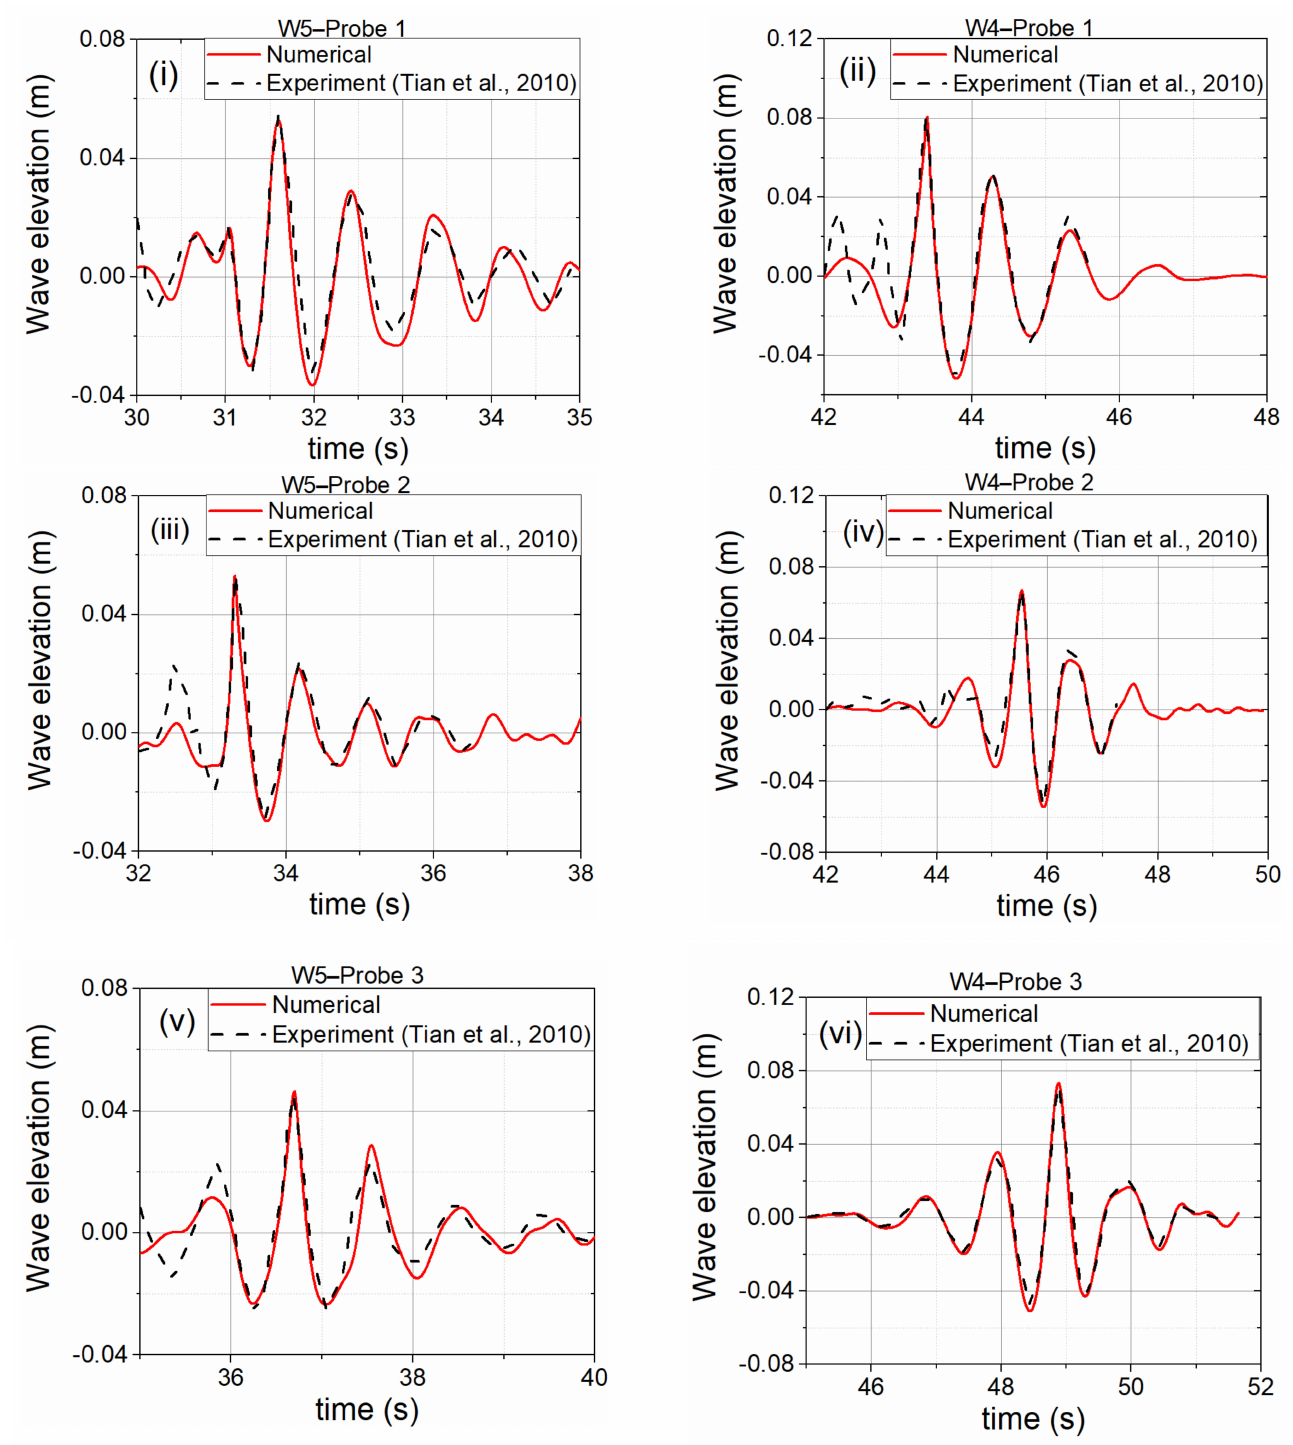
Figure 3. Comparison of surface elevations from the numerical model REEF3D with the experimental results of [31] for wave ids W4 and W5 ( i ) W5-Probe 1 ( ii ) W4-Probe 1 ( iii ) W5-Probe 2 ( iv ) W4-Probe 2 ( v ) W5-Probe 3 and ( vi ) W4-Probe